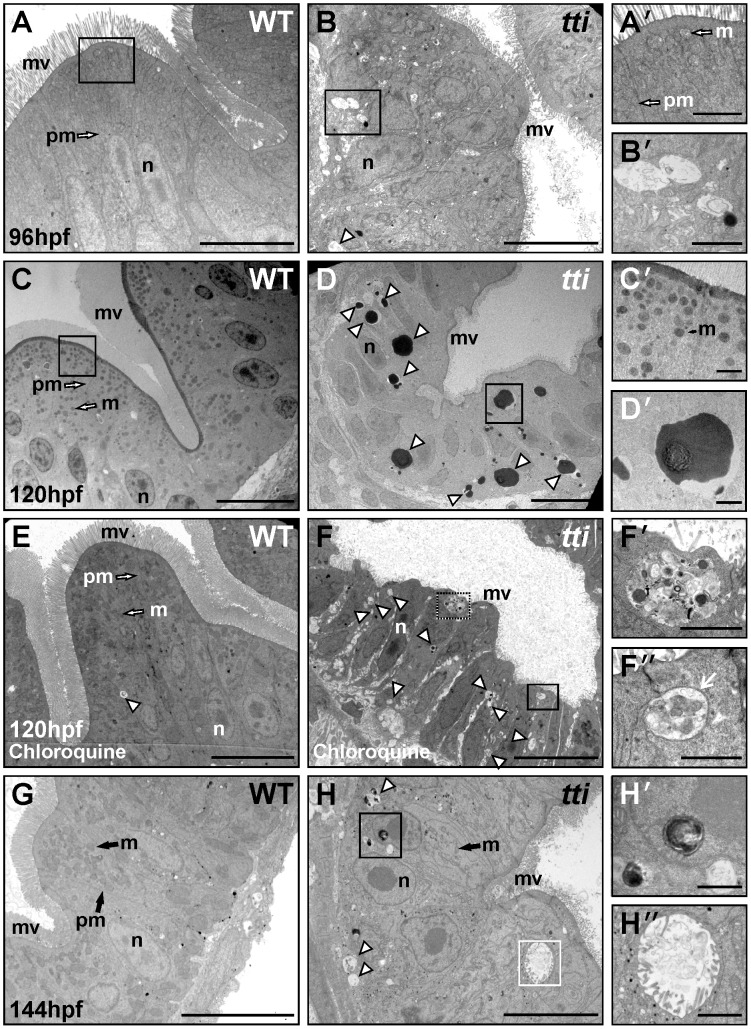
The intestinal epithelial cells (IECS) in ttis450 larvae contain autophagosome- and autolysome-like structures.(A–H) Transmission electron micrographs of WT and ttis450 larvae at 96 hpf (A, B), 120 hpf (C–F) and 144 hpf (G, H). Sections are transverse through the yolk in the region of the intestinal bulb. WT IECs demonstrate well-developed apicobasal polarity as evidenced by basally positioned nuclei (n) and the elaboration of microvilli (mv) projecting from the apical surface into the intestinal lumen. Mitochondria (m) are abundant and plasma membranes (pm) are well defined. The intestinal epithelium in ttis450 is highly disorganized, with shorter and relatively sparse apical microvilli compared to WT. Vesicles resembling autophagosomes (white arrowhead in B) are present in the intestinal epithelial cells of ttis450 larvae (B′ [boxed area in B], H″ [boxed area in H]) but not in WT (A, A′ [boxed area in A] and G). At 120 hpf, electron-dense structures, likely to correspond to autolysosomes, are present in ttis450 larvae (white arrowheads in D, D′ [boxed area in D]), but not WT (C, C′ [boxed area in C]). When ttis450 larvae are treated with chloroquine to block the fusion of autophagosomes with lysosomes, the electron-dense structures are no longer apparent at 120 hpf; instead vesicles more typical of autophagosomes are found (white arrowheads in F). The boxed areas in F (F′ and F″) show vesicles containing debris, including one (white arrow in F″), with a clear double membrane. Scale bars = 10 µm (A–H) and 1 µm (all insets).